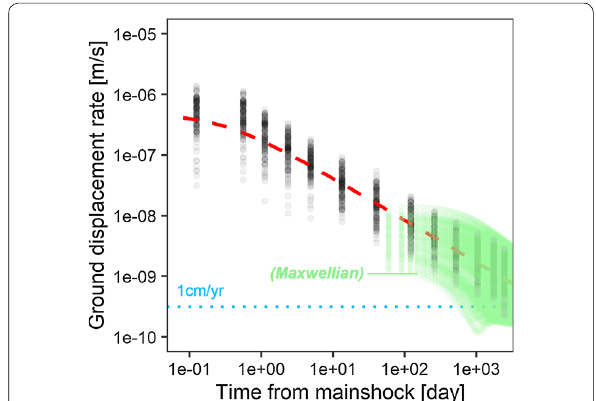
Fig. 7 Comparison between the evolution of the horizontal ground displacement rates (Fig. 2) and a Maxwellian viscoelastic simulation (Suito 2017) after the 2011 Tohoku Earthquake. The green points represent the simulation results of Model 4 (final model) in Suito